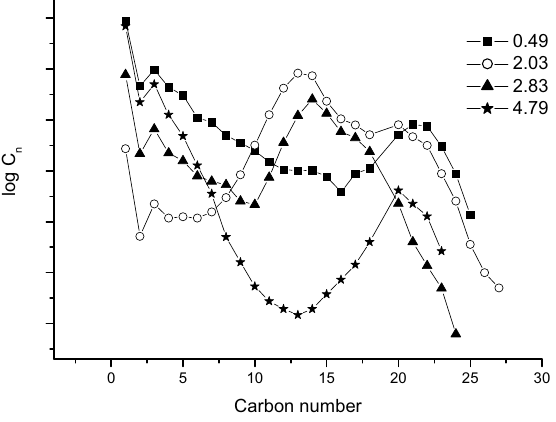
Fig. 6 – Anderson-Schulz-Flory of carbon